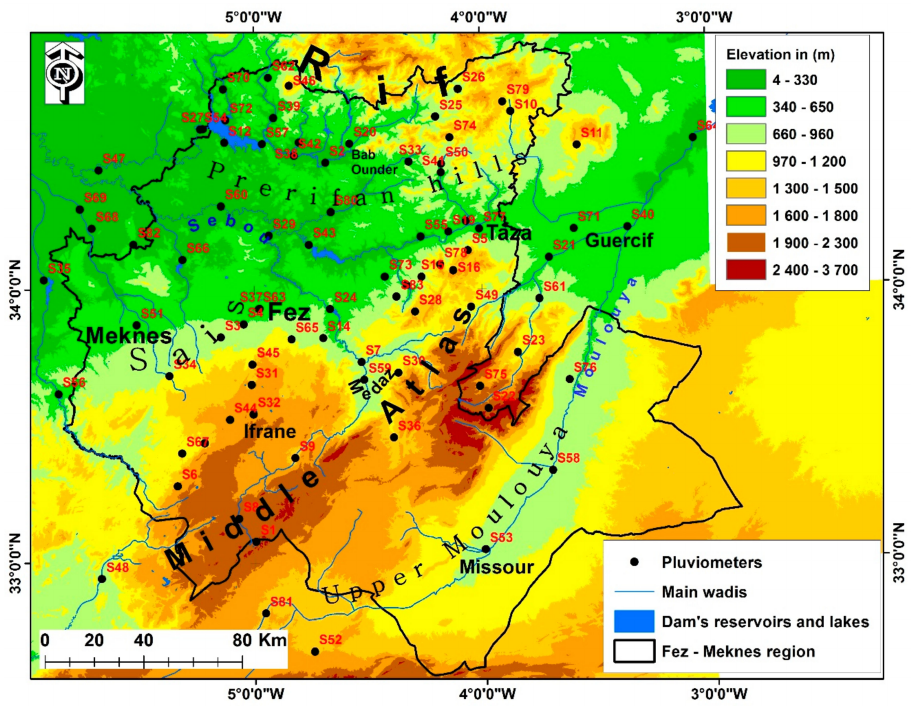
Figure 2. Spatial distribution of rain gauge stations in the Fez-Meknes region and its surrounding areas. Table 1. Geographical location of stations, observation period and percentage of missing